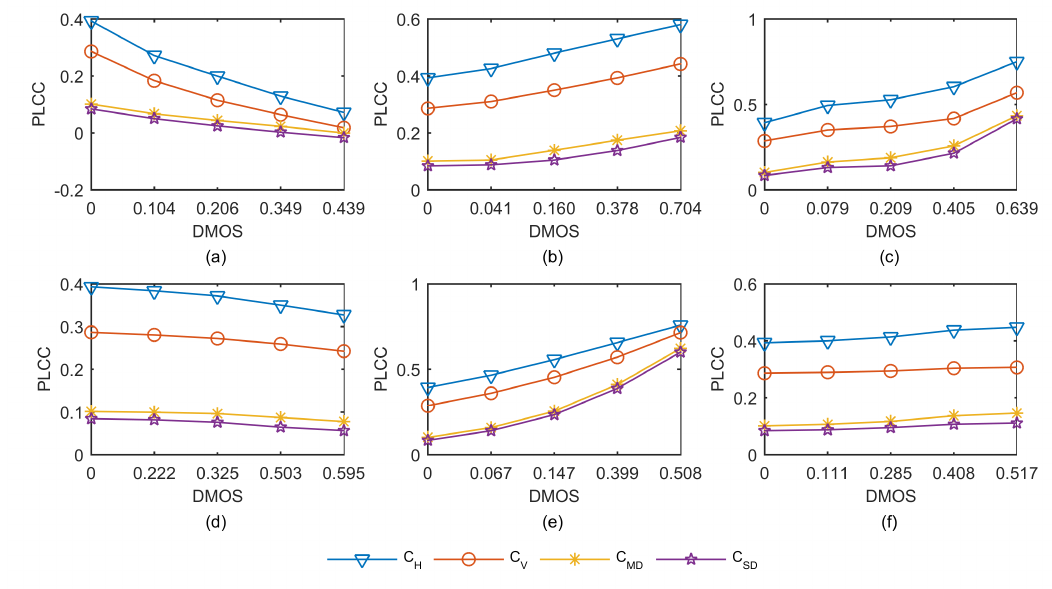
Figure 3. Variation of the PLCC values along four orientations for six types of distorted images in CSIQ database [29]. Each distortion type contains four distorted images with different difference mean opinion scores (DMOS) values, where DMOS = 0 corresponding to PLCC values of the pristine image: ( a ) additive Gaussian white noise (WN) distorted images; ( b ) JPEG compressed (JPEG) images; ( c ) JPEG2000 compressed (JP2K) images; ( d ) pink Gaussian noise (PGN) distorted images; ( e ) Gaussian blurred (GB) images; and ( f ) global contrast decrements (GCD)